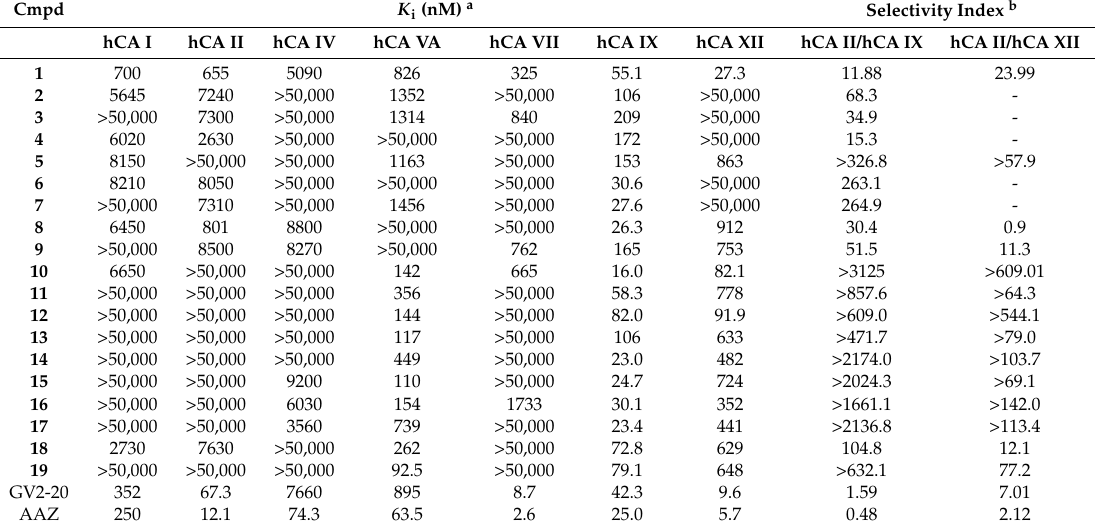
Table 1. Inhibition data of hCA I, hCA II, hCA IV, hCA VA, hCA VII, hCA IX, hCA XII with compounds 1 – 19 , GV2-20, and the standard sulfonamide inhibitor acetazolamide (AAZ) by a stopped flow CO 2 hydrase